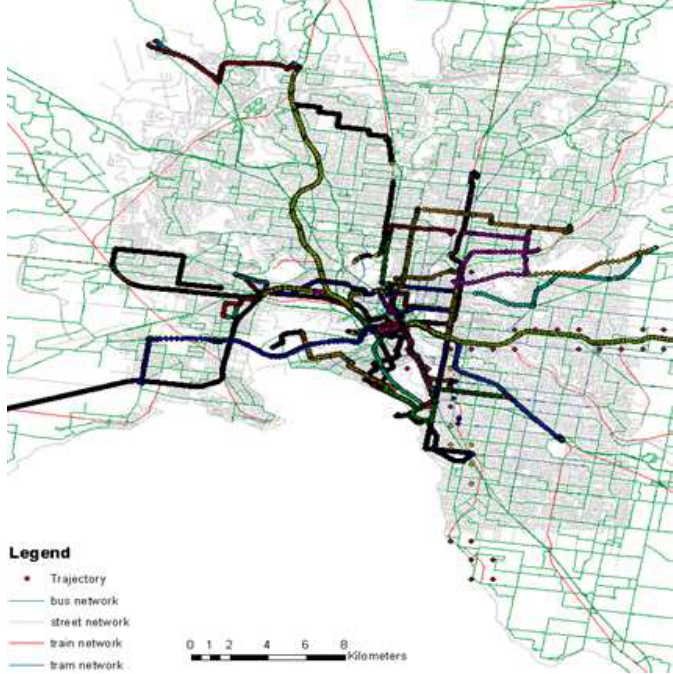
Figure 7. Data set 1: Low frequency (1Hz, 2Hz) GPS trajectories in Greater